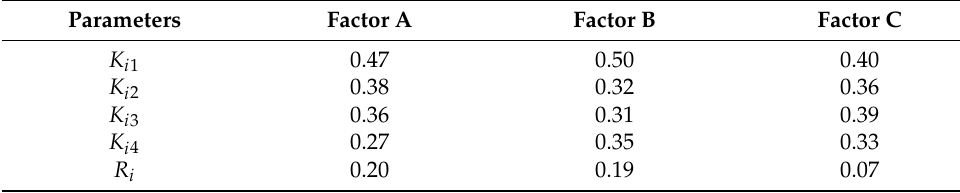
Table 10. Range analysis results for the standard deviation of